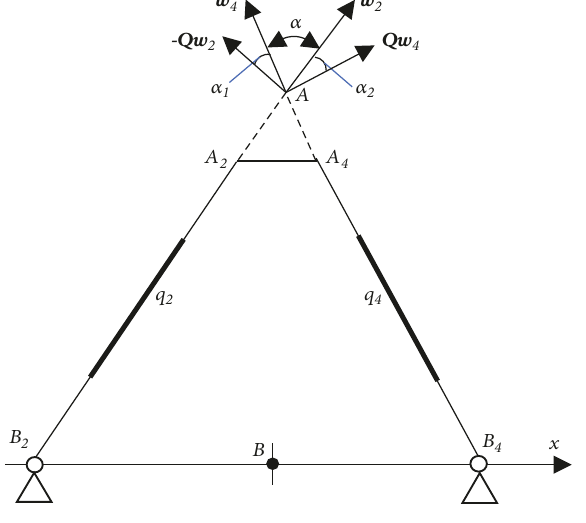
Figure 12: Pressure angles between SPS limbs.